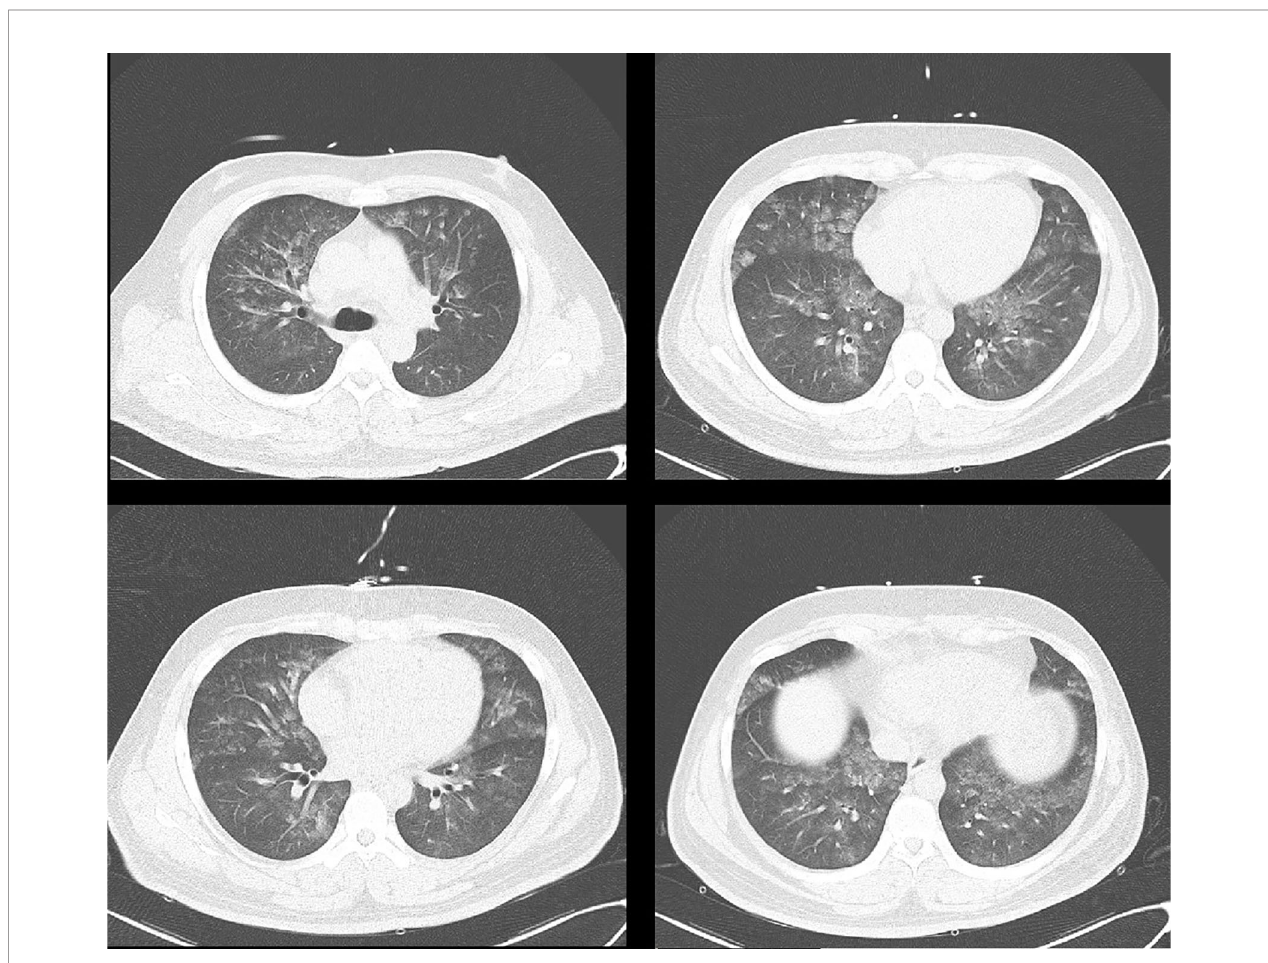
FIGURE 1 | Diffuse lesions in both lungs, showing patchy high-density shadow and ground-glass